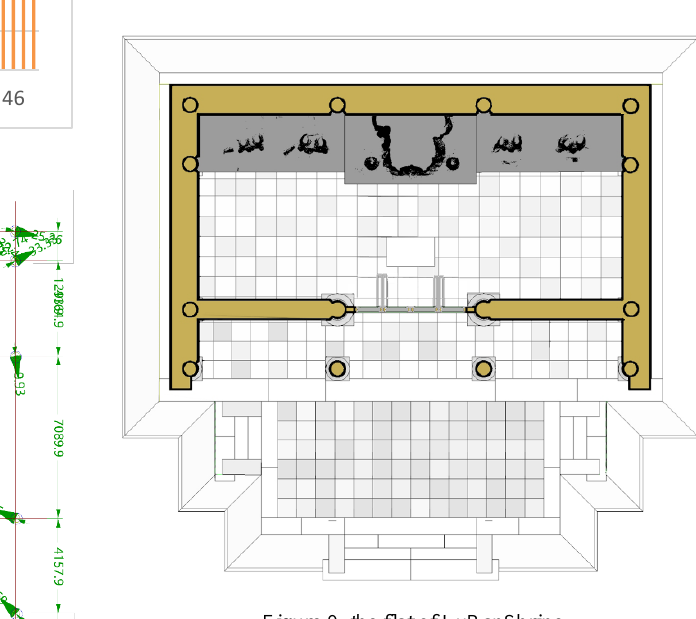
Figure 9. the flat of LuBanShrine